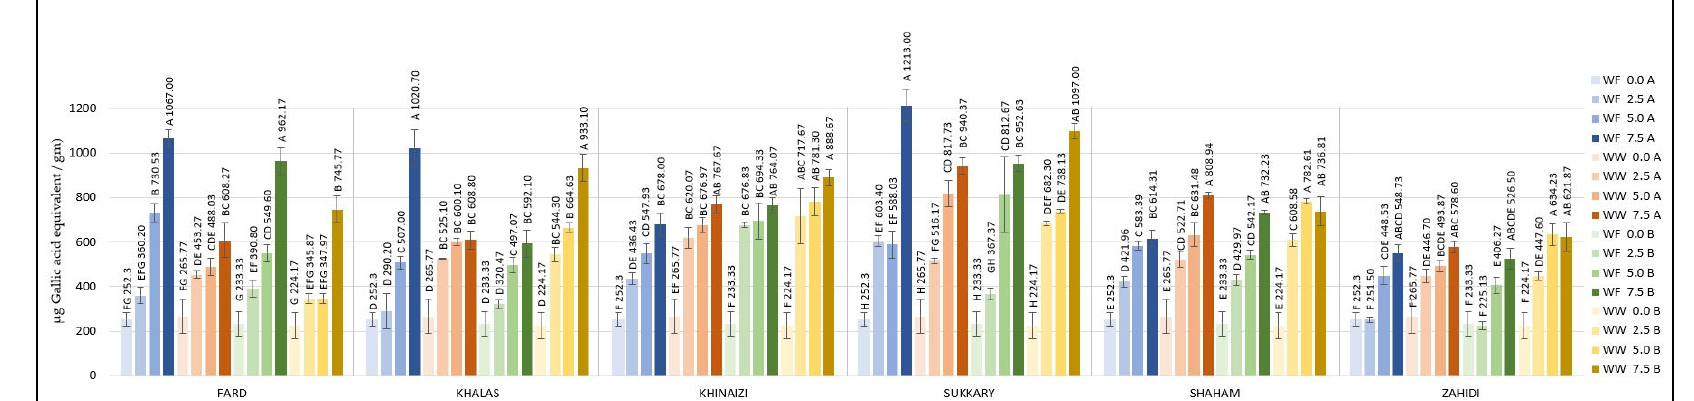
Figure 3. TPC of composite cookies formulated with 2.5%, 5%, and 7.5% substitution of flour by date seed powder. (Data expressed as Gallic acid equivalent per gram ( μ g / g) of the cookie sample. Different uppercase superscript letters in a variety denote significant differences, p < 0.05. (A ‐ 180 °C, B ‐ 200 °C).